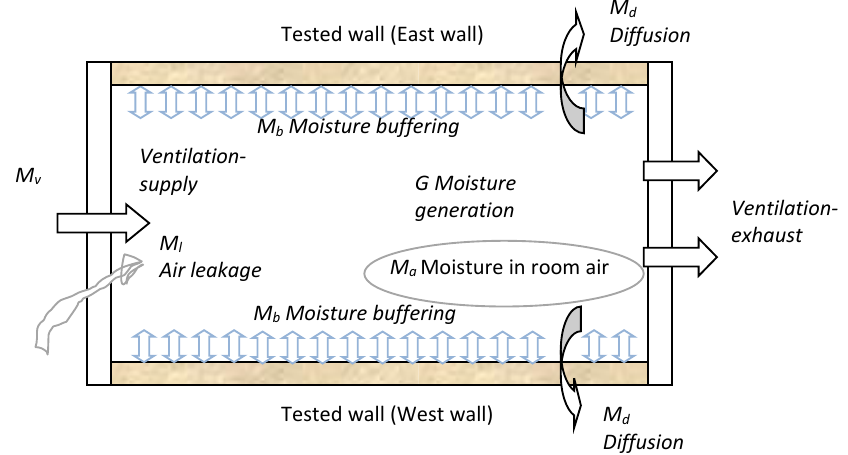
Figure 2. Moisture accumulation in the test room (Reproduced with permission from